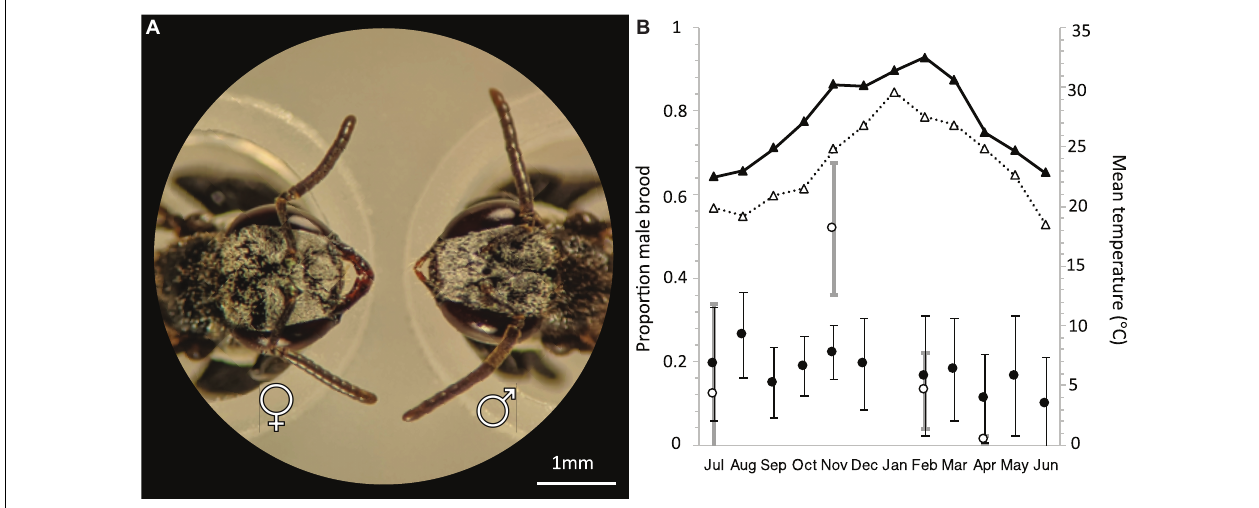
FIGURE 2 | (A) Head morphology of female (left) and male (right) T. carbonaria. Females have 9 antennal segments and large mandibles. Males have 10 antennal segments and small mandibles (scale bar: 1 mm). (B) Annual average male brood investment per month for T. carbonaria in Southern Queensland (black circles, n = 4 colonies per month, 2016–2017) and Sydney (white circles, n = 4 colonies per month, 2018–2019). Triangles represent the Maximum Temperature Mean in Brisbane (black) and Sydney (white) based on data from the Bureau of Meteorology,